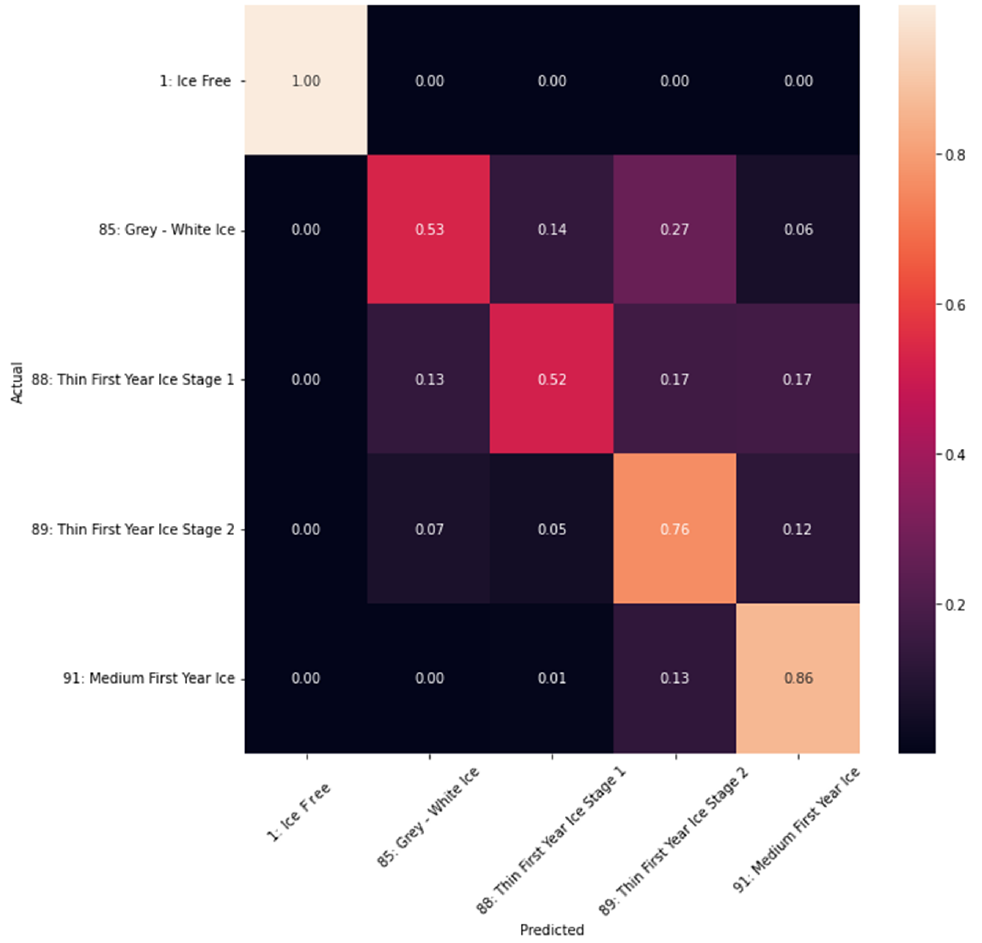
Figure 9. Confusion Matrix.